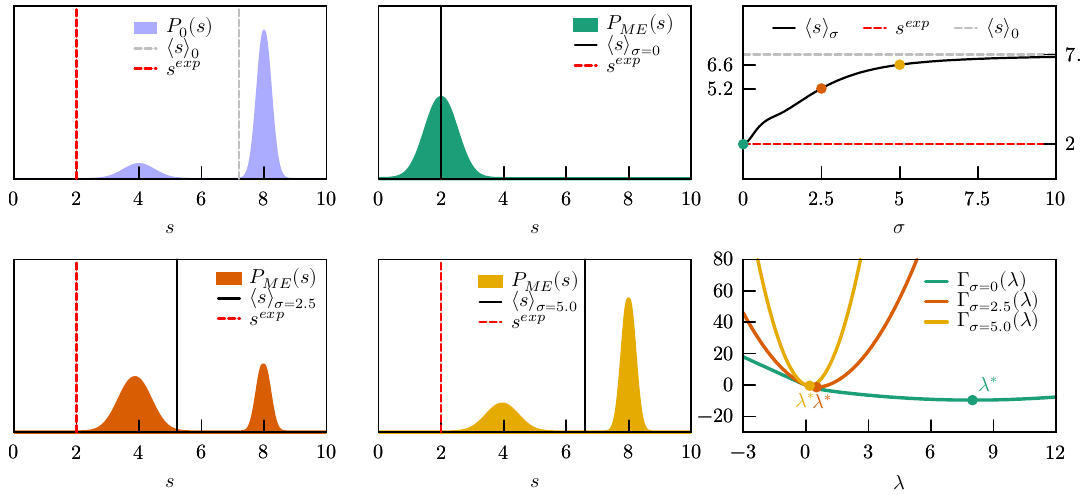
Figure 3. Same as Figure 2, but the experimental value is here set to s exp = 2, which is almost incompatible with the prior